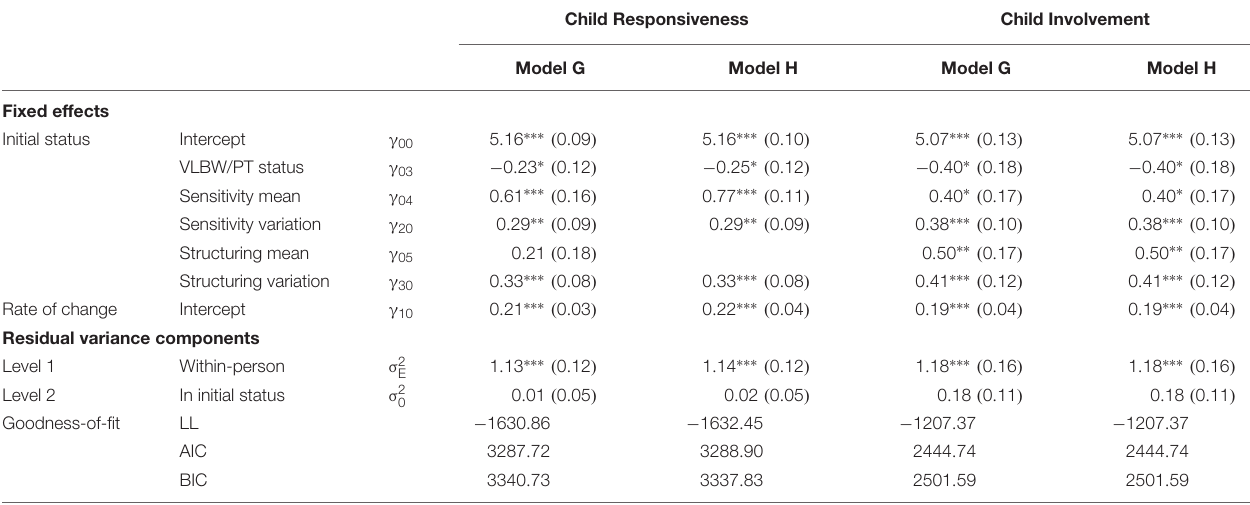
TABLE 7 | Final models for child responsiveness and child